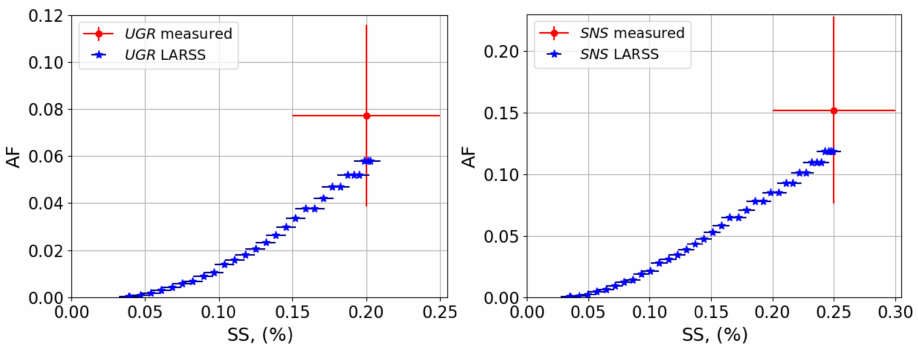
Figure 7. AF of the aerosol in Granada (UGR) and Sierra Nevada (SNS) for different maximum SS.